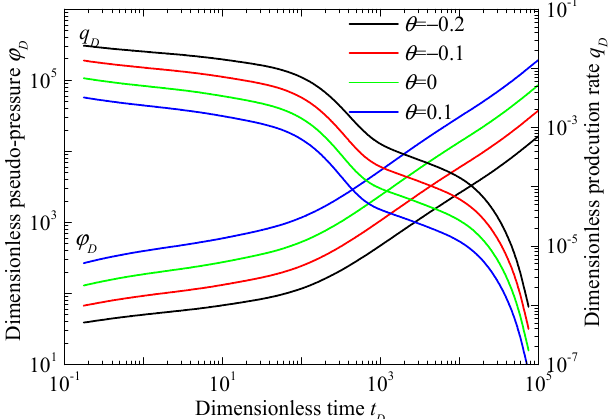
Figure 5. Comparison of production rate and pseudo-pressure with different tortuosity index of induced-fracture θ by FMFM ( d fs = 2 and d fa = 2).